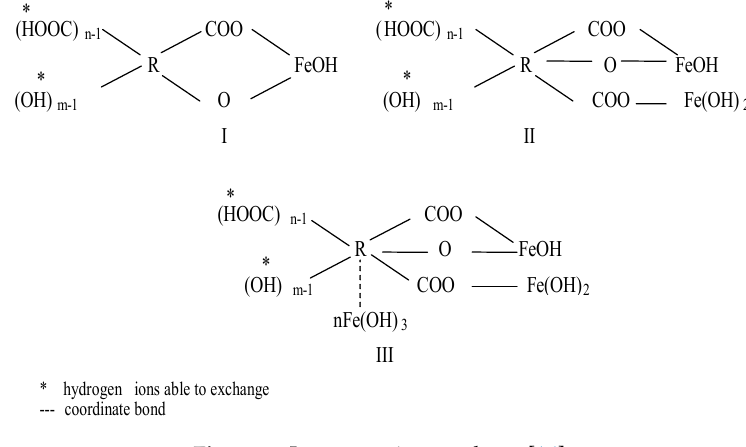
Figure 1. Iron-organic complexes [16].